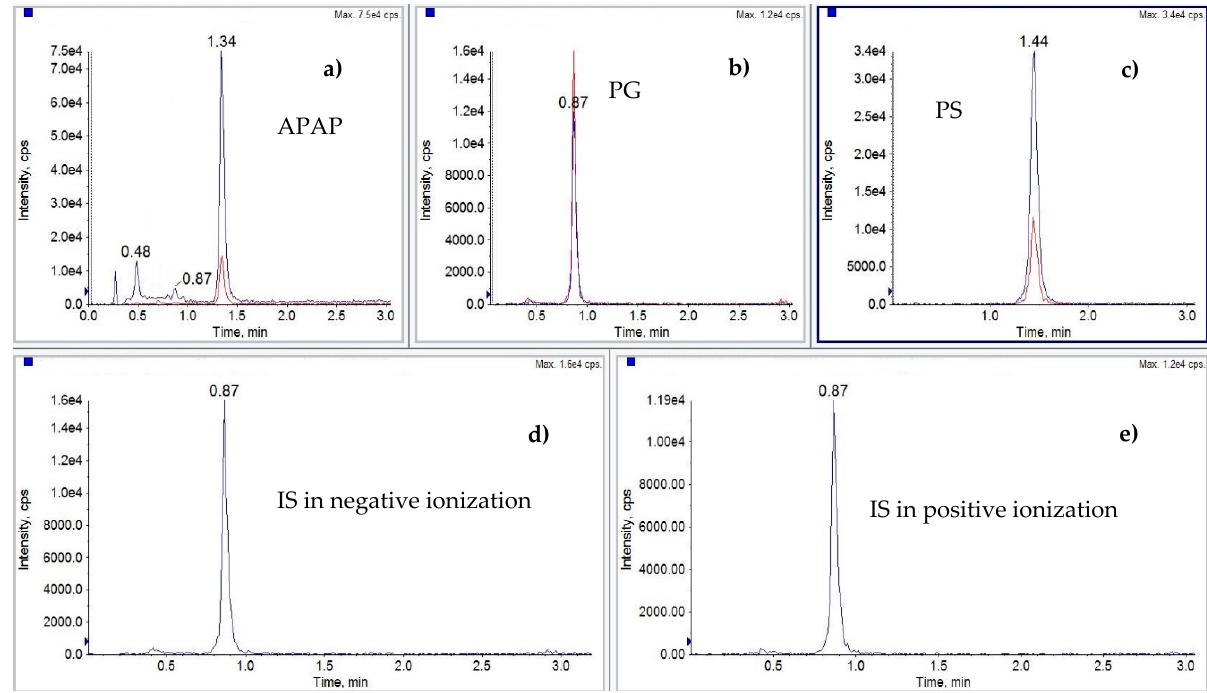
Figure 1 . UHPLC-MS/MS XICs, control muscle sample from geese spiked with: ( a ) paracetamol (APAP), ( b ) p-Acetamidophenyl β -D-glucuronide sodium salt (PG), ( c ) Paracetamol sulfate potasium (PS), ( d ) and ( e ) 4-Acetamidophenyl β -D-glucuronide-d3 sodium salt (PG-d3) IS in negative and positive ionization, respectively. Paracetamol and metabolites were spiked at 50 µg/kg and internal standard at 25 µg/kg.